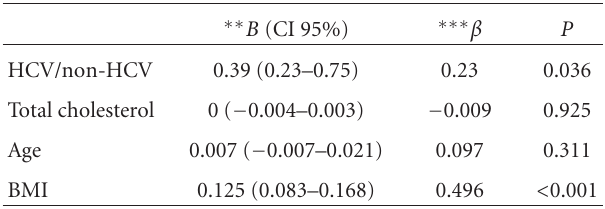
Table 4: Influence of total cholesterol, age, and BMI in the results of the HOMA-IR natural logarithm in HCV and non-HCV individ- uals: a multiple linear